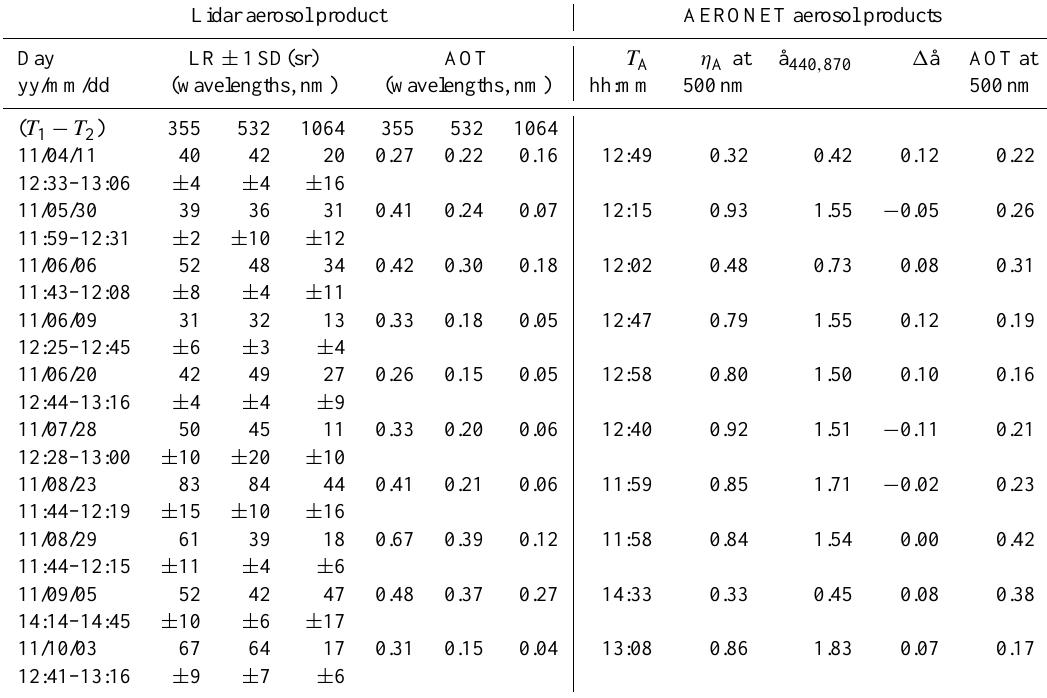
Table 2. Lidar ratios (LR) ± 1 standard deviation (SD) retrieved from the implemented iterative procedure and AOTs at the laser wavelengths. Measurement day and time interval ( T 1 − T 2 (UTC)) during which lidar measurements were performed are also provided. The fine-mode frac- tion ( η A ) at 500nm, å 440 , 870 , and 1 å = å 440 , 675 − å 500 , 870 values retrieved from the AERONET sun photometer measurements performed at the time T A (UTC) are given in addition to the AERONET AOT at